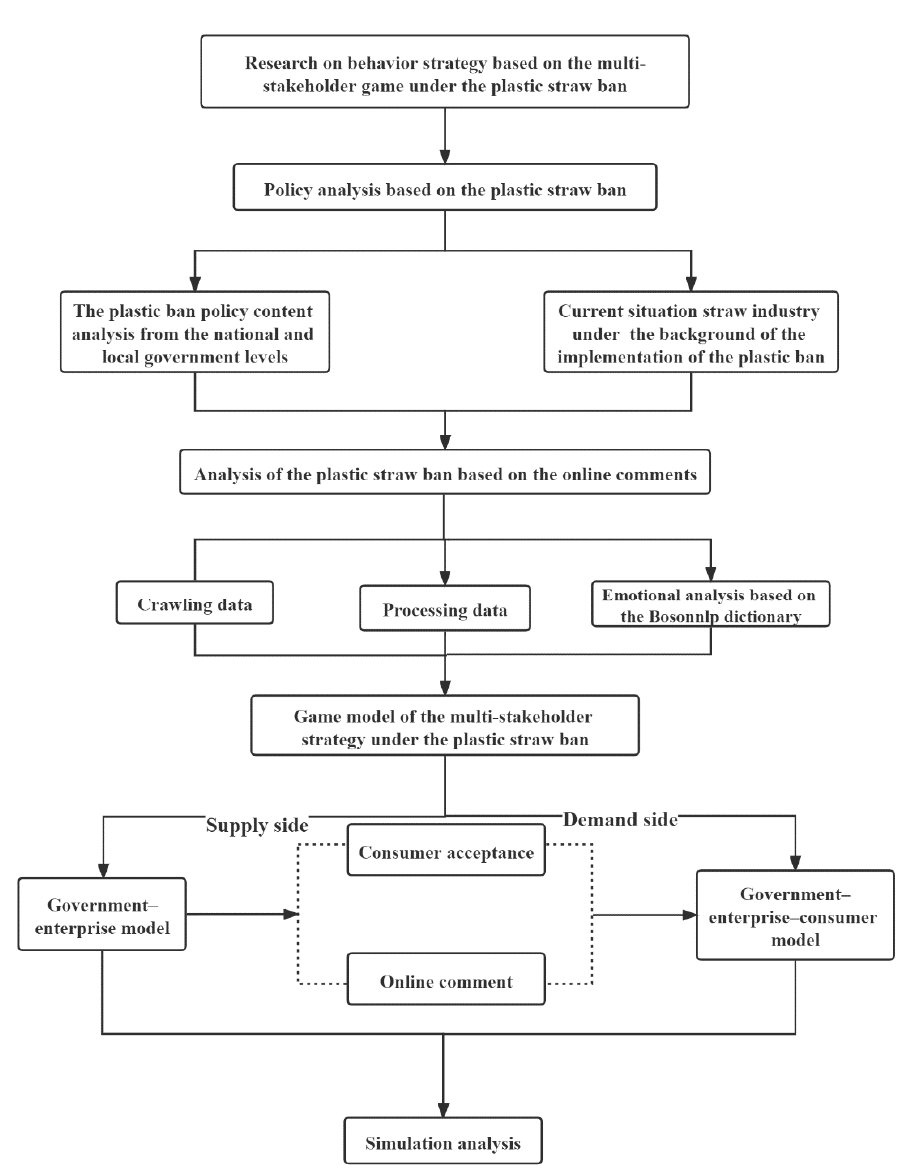
Figure 1. Research framework of this paper.